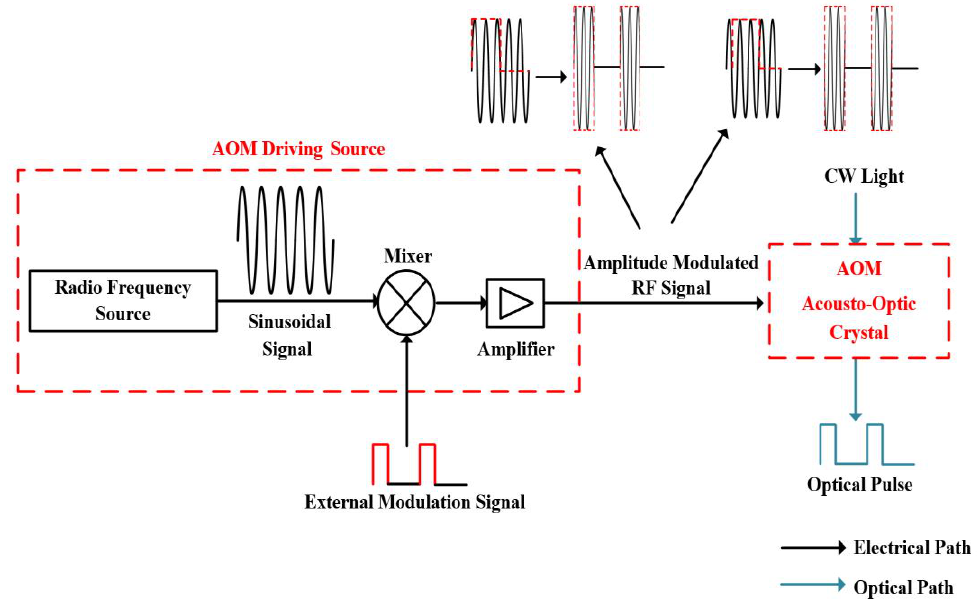
Figure 2. Working principle of an acoustic optical modulator